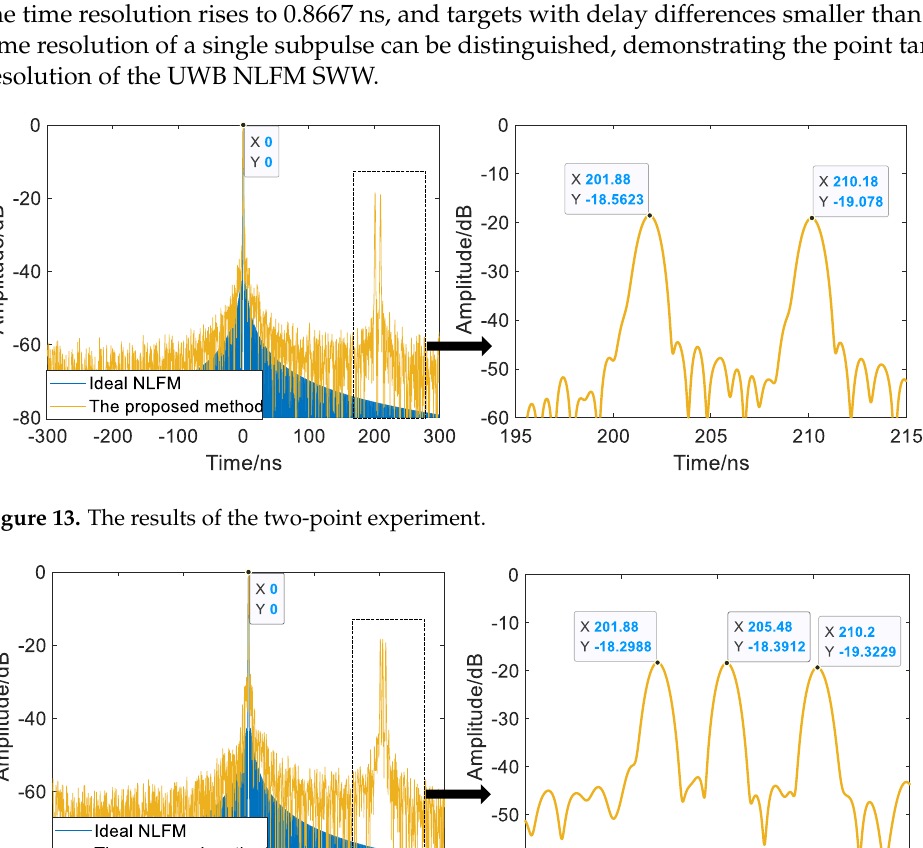
Table 4. The group delay of point targets.